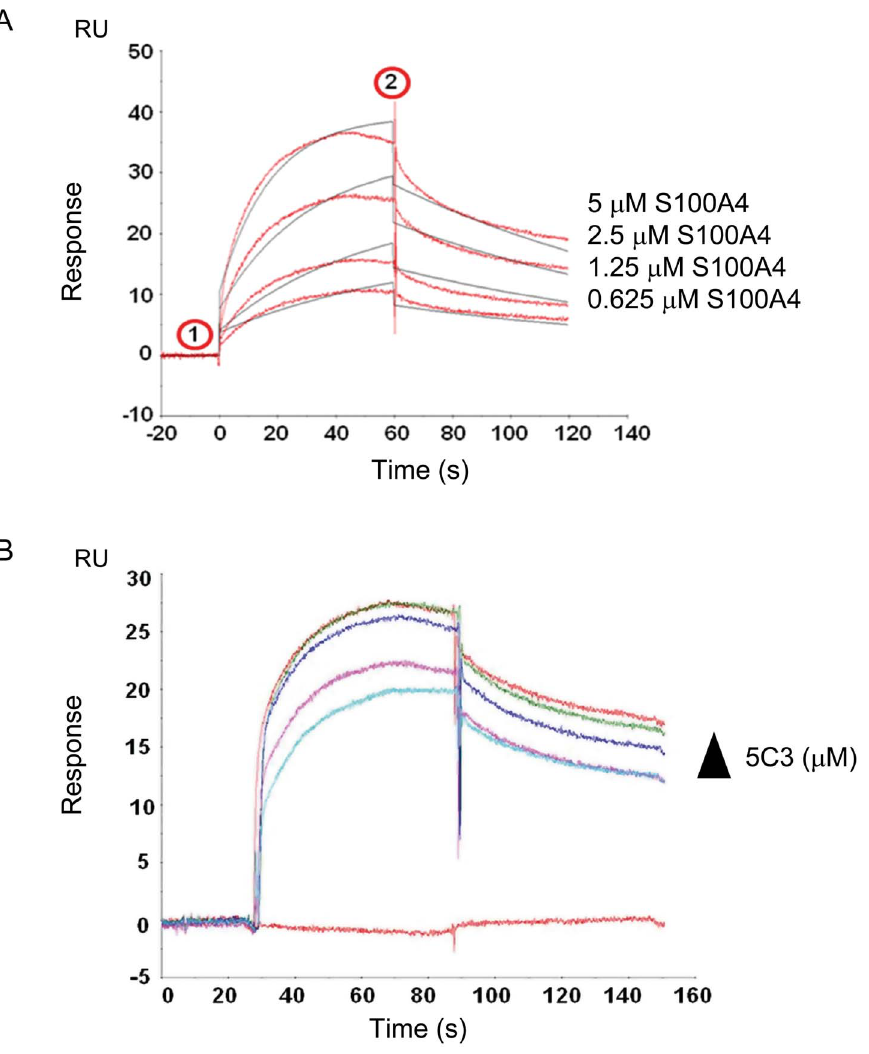
Figure 4. S100A4 interacts with RAGE. A) Molecular interaction between S100A4 and RAGE by SPR. Overlayed sensorgrams of interaction between immobilized RAGE and S100A4 at four different concentrations. Numbers 1 and 2 indicate the start and the end of S100A4 injection, respectively. B) Dose-response inhibition of S100A4-RAGE interaction by 5C3 mAb. Antibody was used at 60–500 nM for 2 m M S100A4.